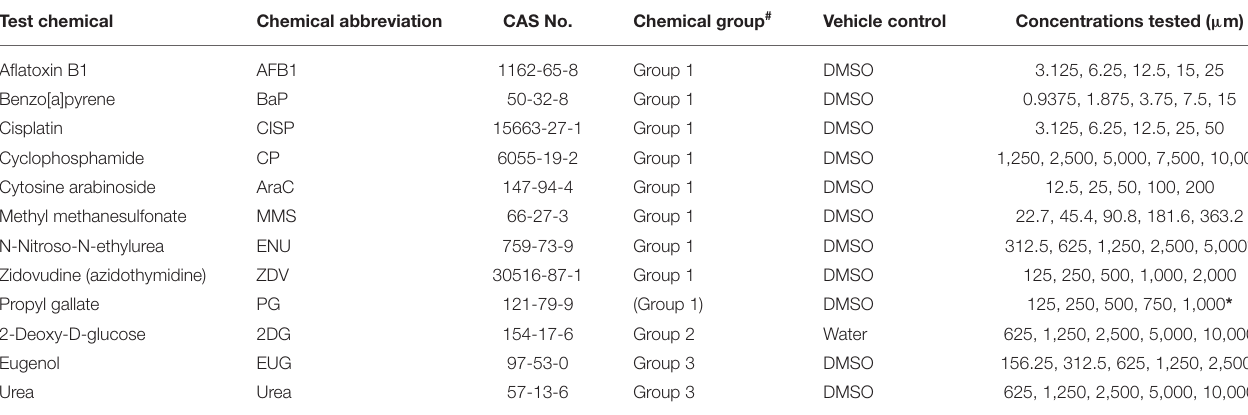
TABLE 2 | Experimental information for DDI (genotoxic) and non-DDI (non-genotoxic) test chemicals used in this study. Test